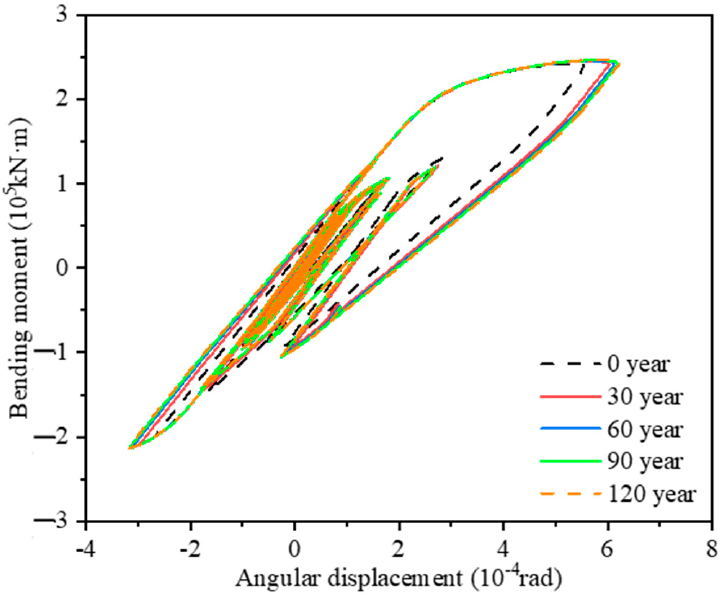
Figure 21. Bending moment–angle curve of pier bottom under LRB deterioration.